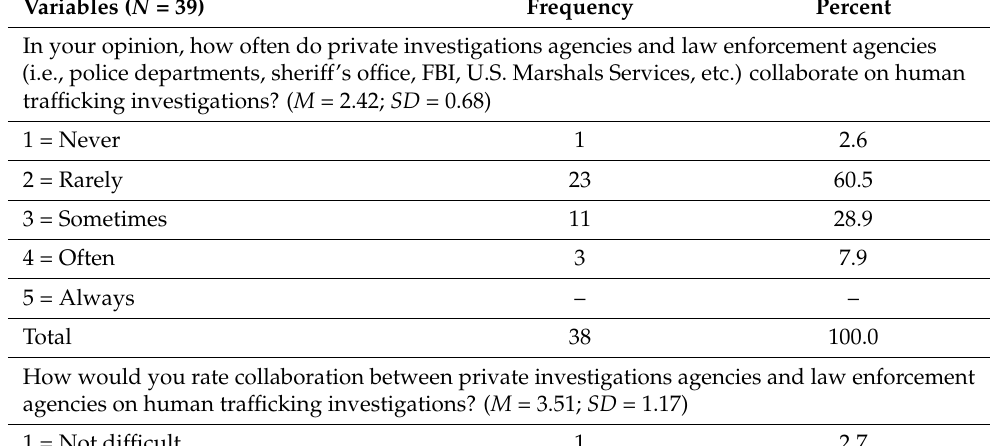
Table 2. Survey participants’ knowledge and perceptions of PIAs’ collaboration with LEAs. Variables ( N = 39) Frequency